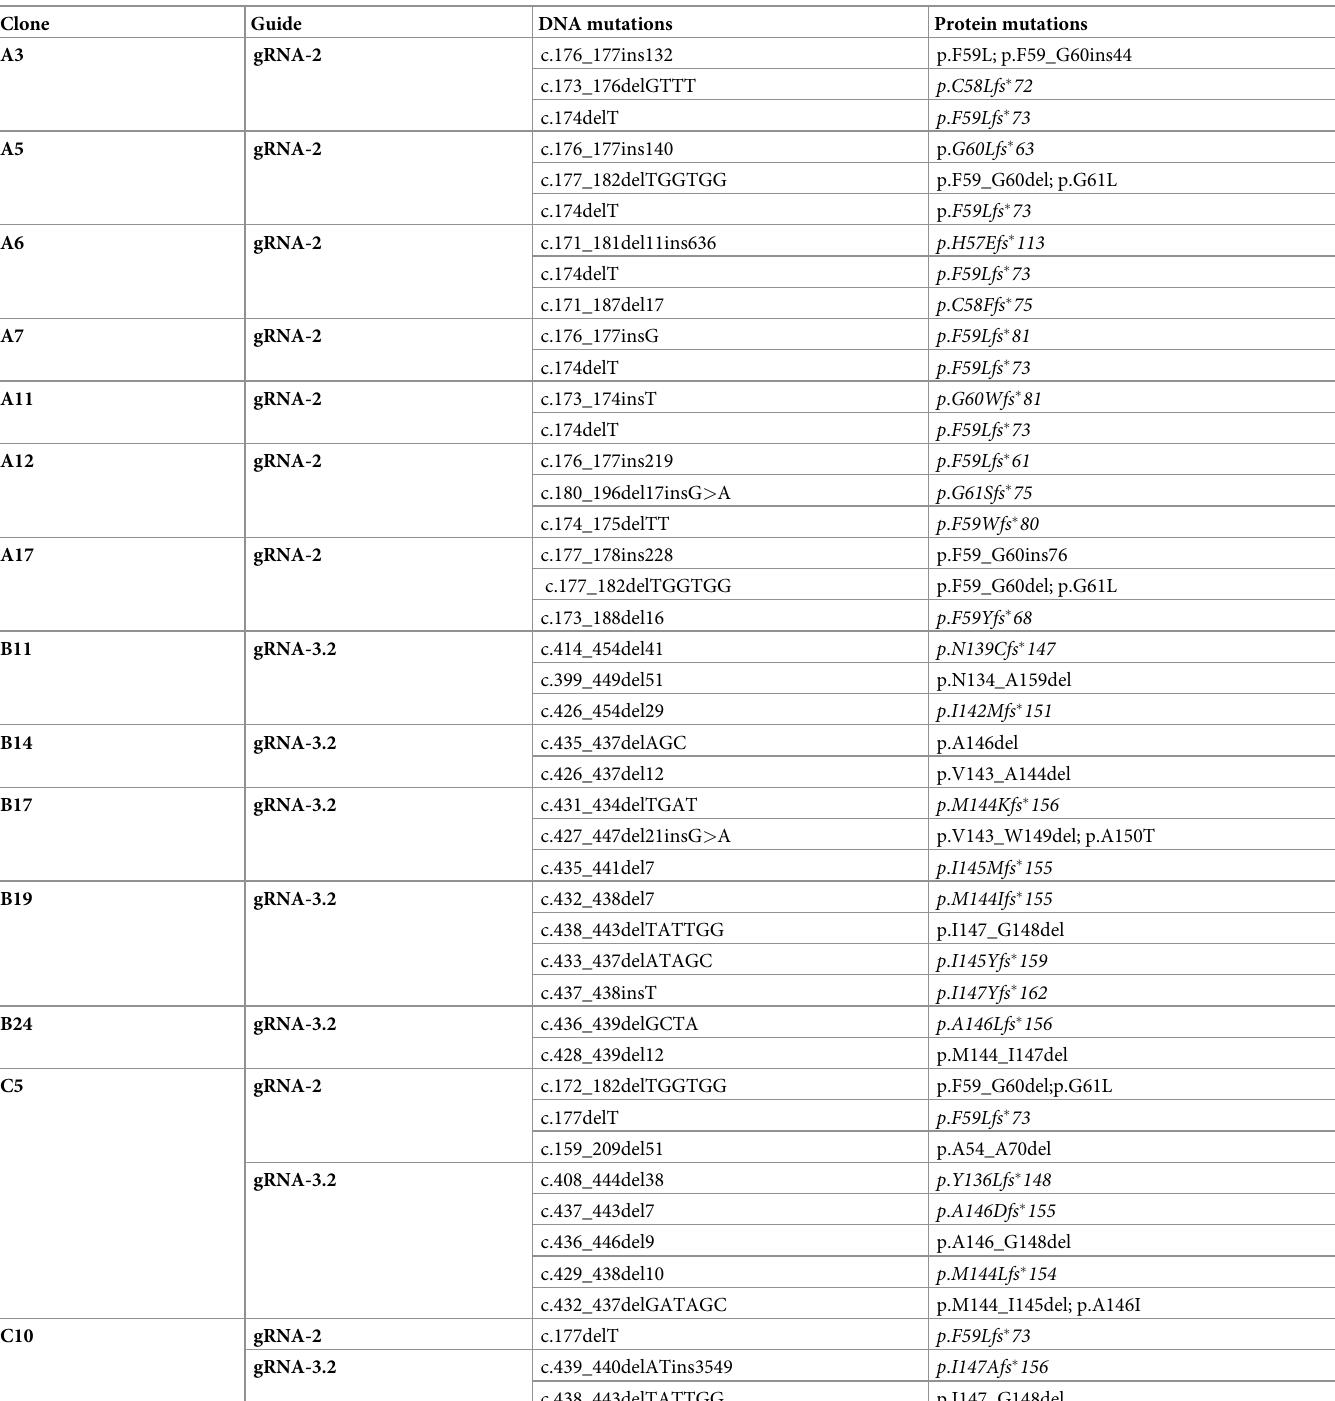
Table 1. Mutations identified in gRNA-2 and gRNA-3.2 transfected